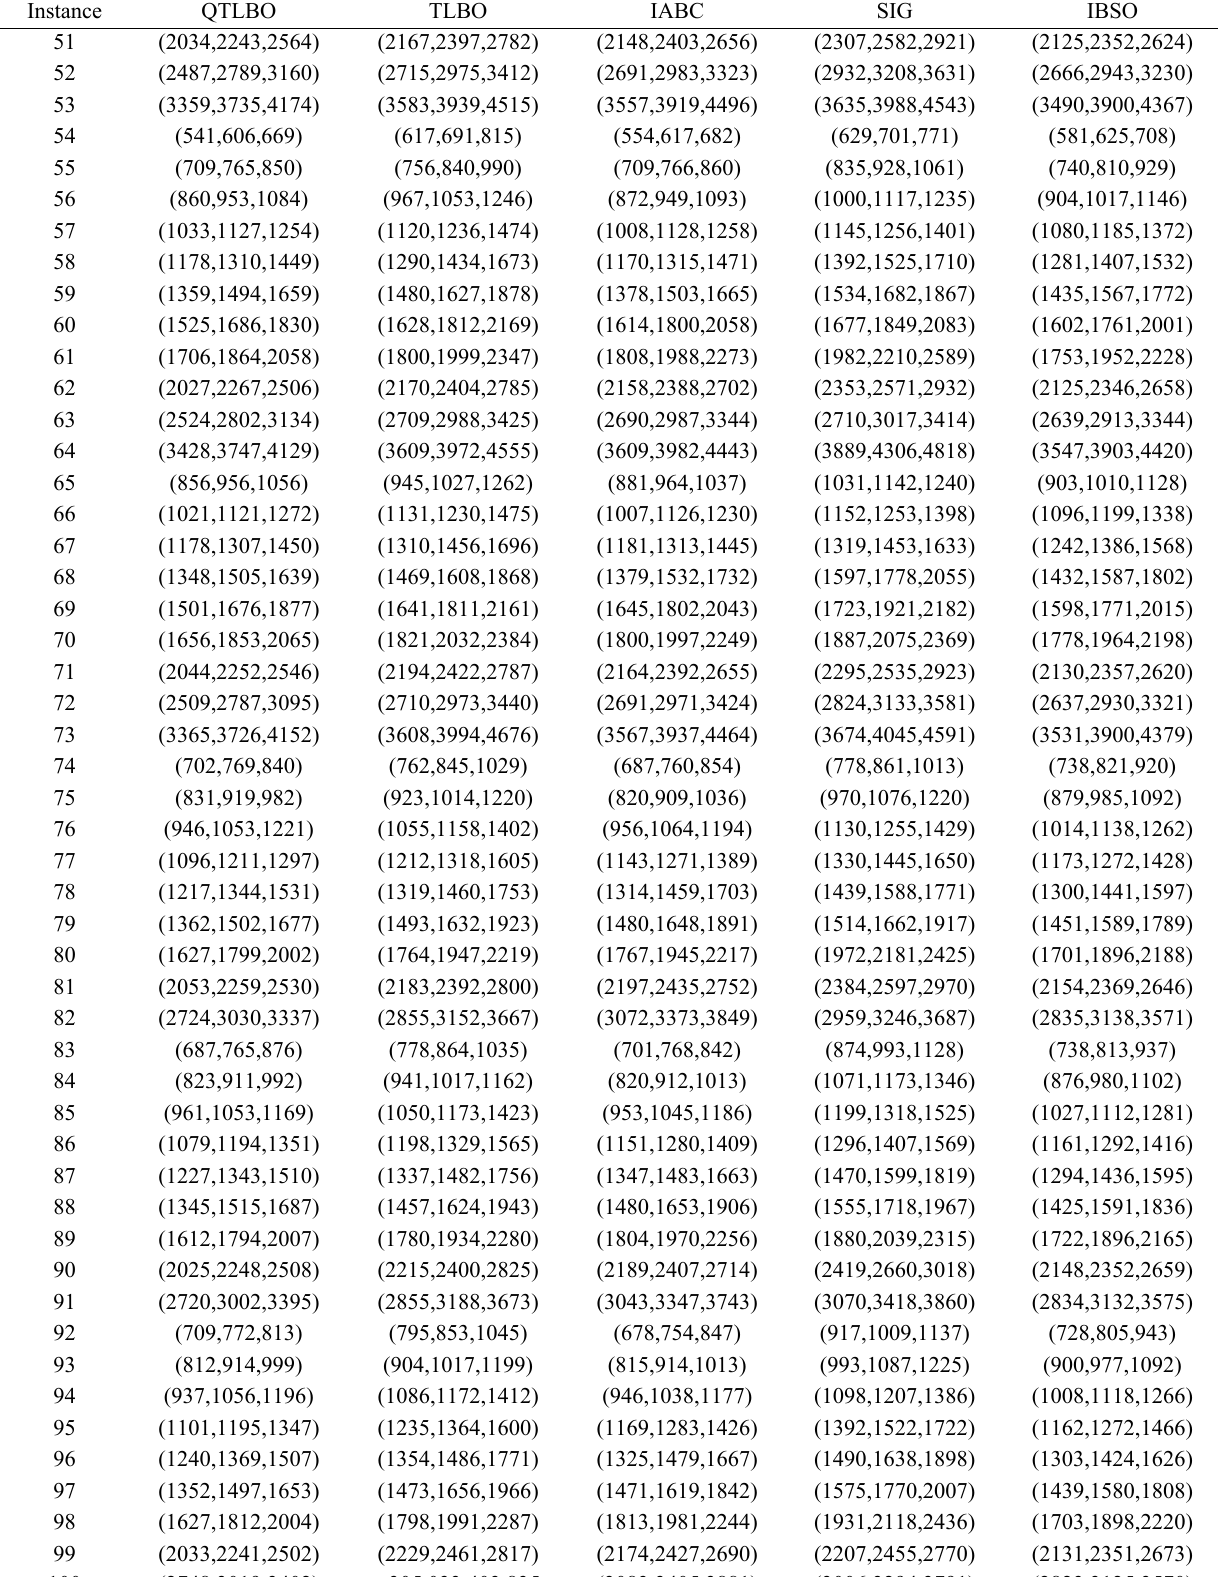
Max Table 10 Computational results of all algorithms on for instances